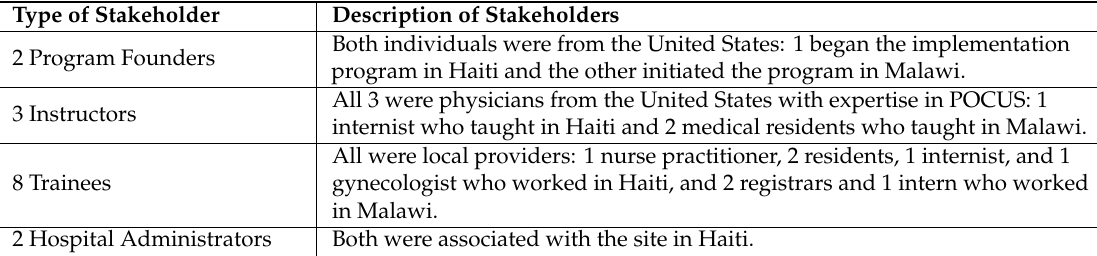
Table 2. Stakeholder interviewees and their role in POCUS